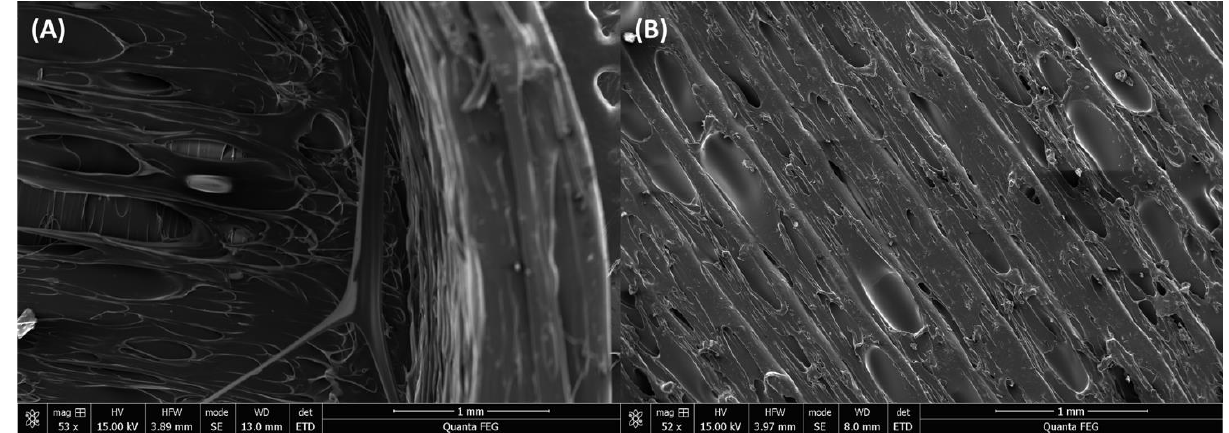
Figure 9. Scanning electron microscopy (SEM) images of hollow print showing: ( A ) the edge of the internal structure, and ( B ) the surface morphology of the sealed top.